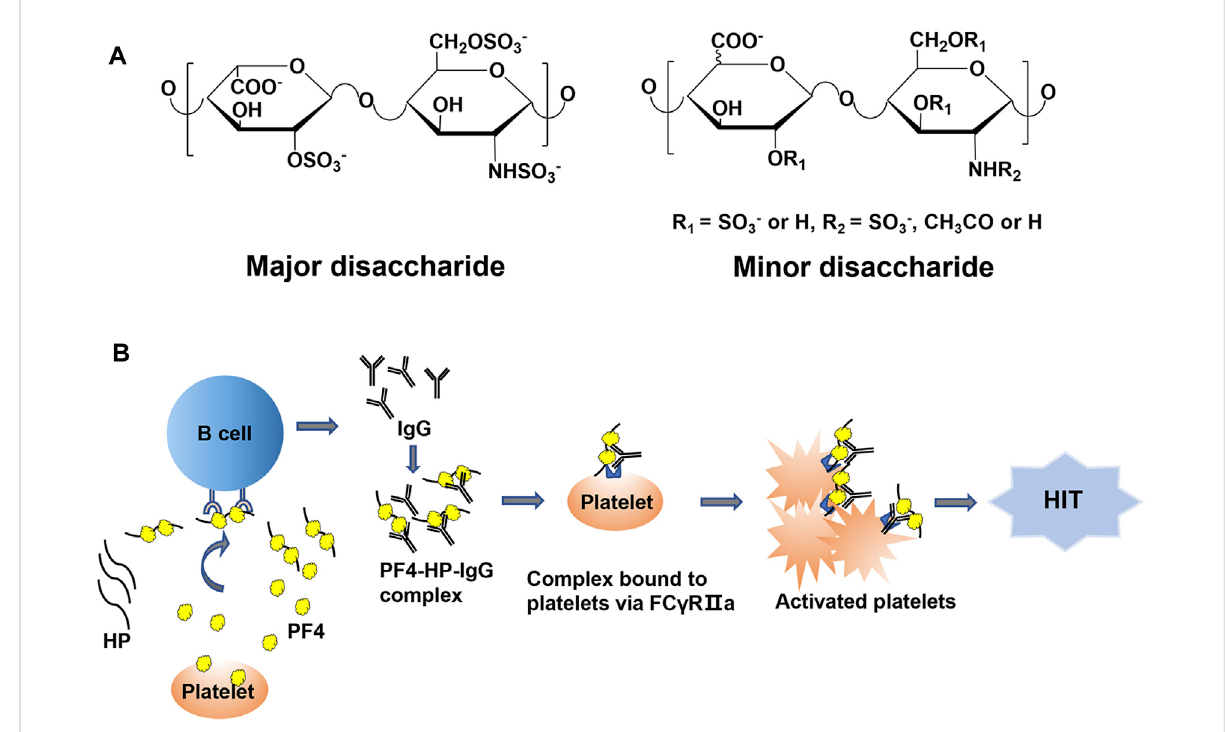
FIGURE 1 (A) The structure of HP. (B) The pathophysiologic process of